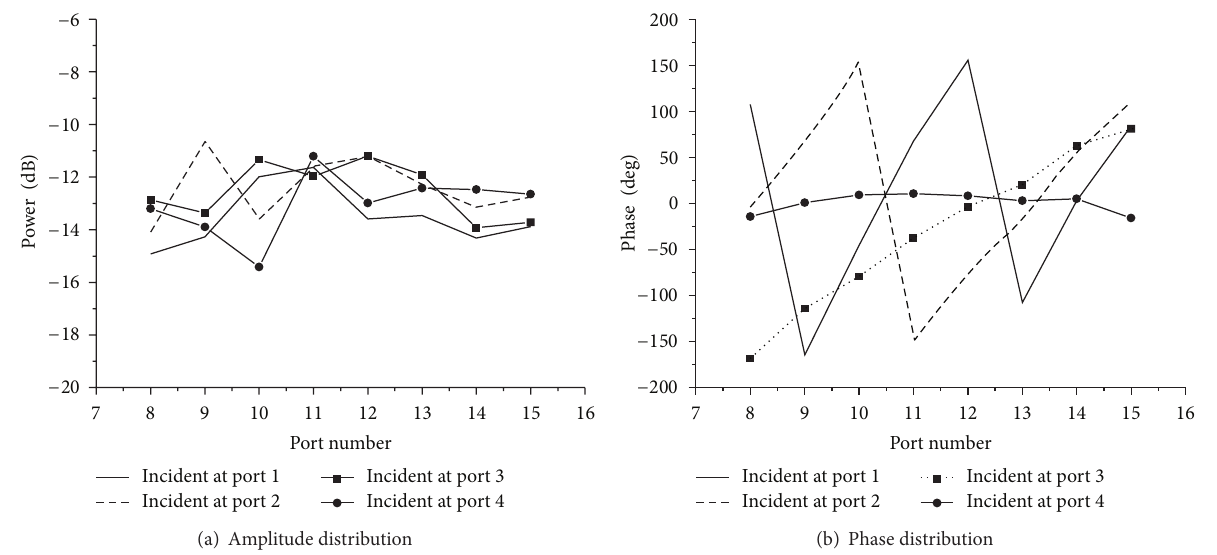
Figure 3: Power distribution at array ports.